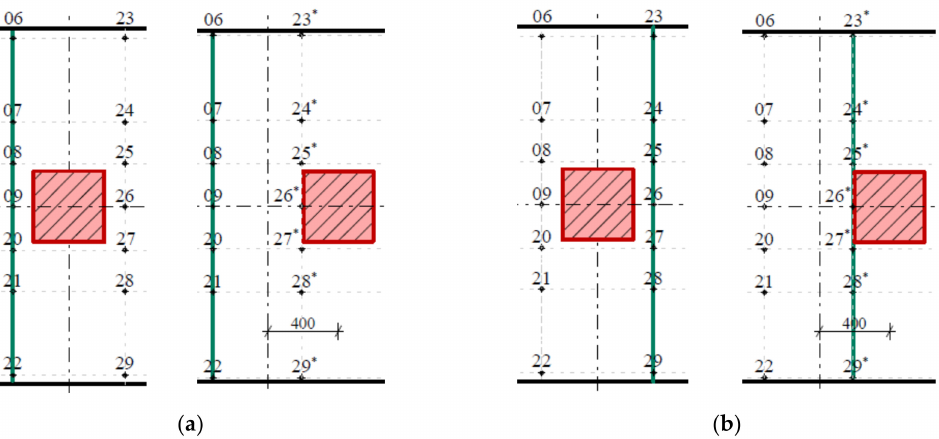
Figure 13. Monitored 2D sections: ( a ) first monitored 2D section for centrically loaded slab G10 (left) and eccentrically loaded slab G11 (right); ( b ) second monitored 2D section for centrically loaded slab G10 (left) and eccentrically loaded slab G11